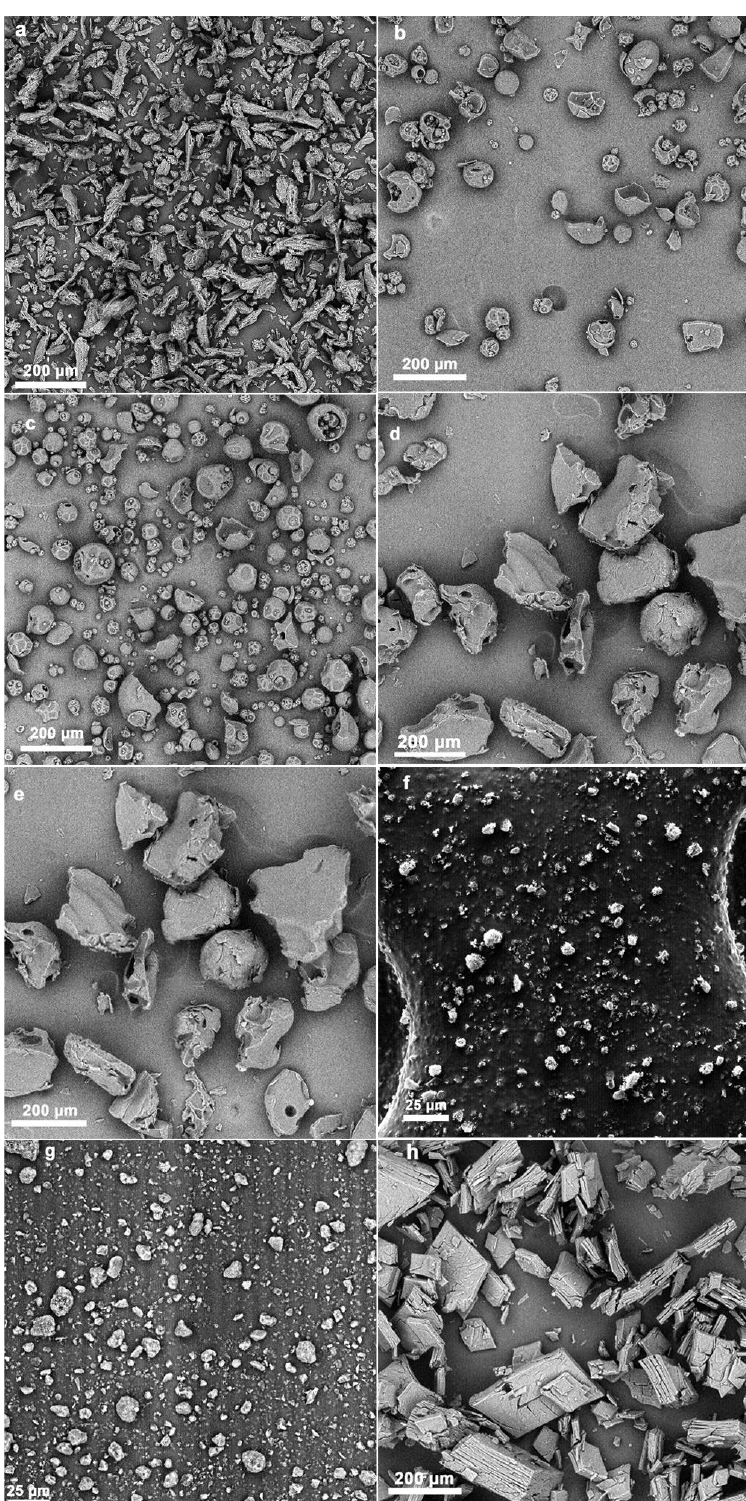
Figure 1. SEM images of particles ( a ) MCC; ( b ) PVP K17; ( c ) PVP K25; ( d ) PVP K90; ( e ) PVA